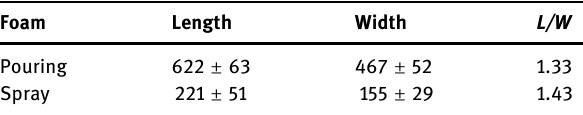
Table 4: Cell sizes of pouring and spray foams ( μ m )